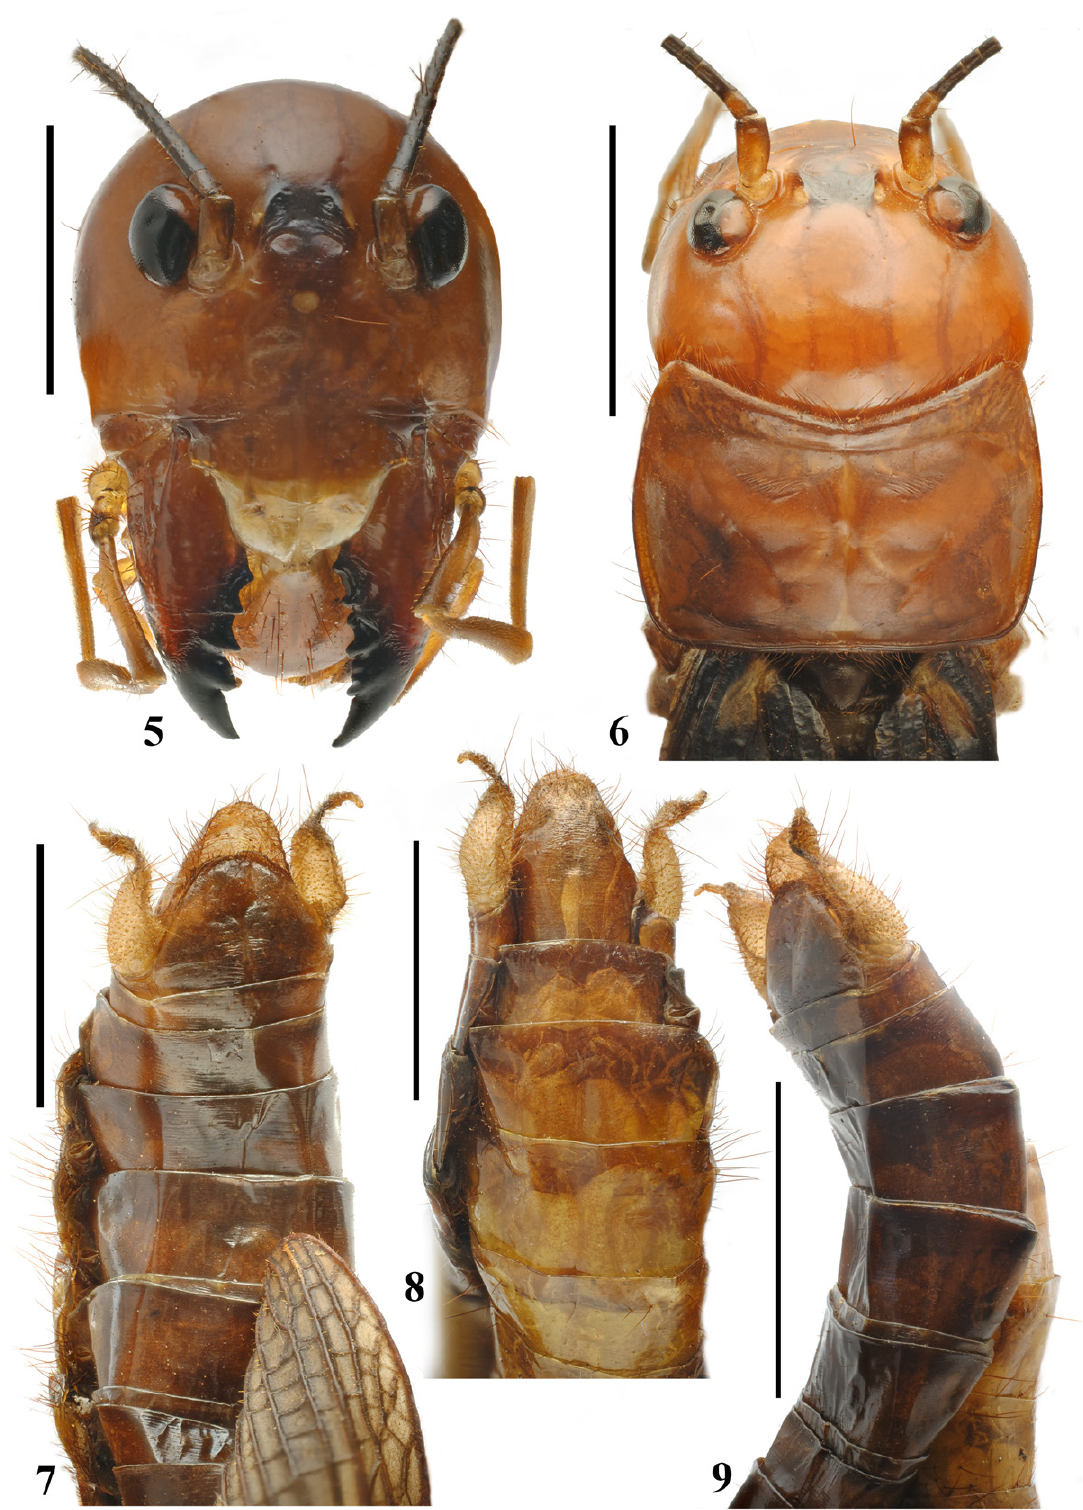
Figs 5–9. Oryctopterus varuna sp. nov. Paratype, ♂ (NBAIR). 5 . Head, frontal view. 6 . Head and pronotum, dorsal view. 7–9 . Apex of abdomen. 7 . Dorsal view. 8 . Ventral view. 9 . Lateral view.Scale bars = 5